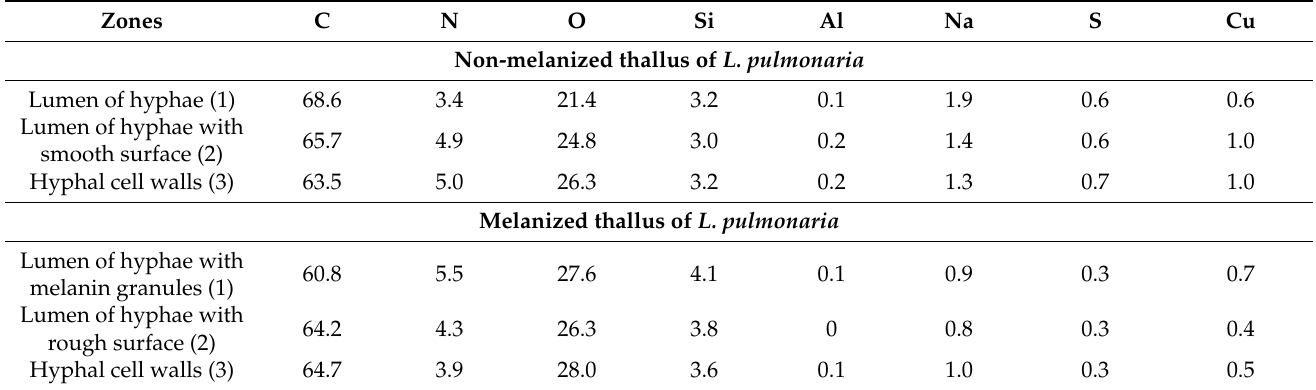
Figure 4. SEM image of cross sections from non-melanized ( A ) and melanized ( B ) Lobaria thalli with three areas selected for elemental composition analysis: ( A )—Lumen of hyphae (1), Lumen of hyphae with smooth surface (2), Hyphal cell walls (3); ( B )—Lumen of hyphae with melanin granules (1), Lumen of hyphae with rough surface (2), Hyphal cell walls (3). SEM image of extracted and purified melanin from Lobaria pulmonaria ( C ) and EDX spectrum of elemental composition (insert). Bar = 1 μ m. In both thalli, all zones were mostly comprised of C, N, and O (Table 1). Interestingly, the relative weight of N in zone 1 with melanin-like granules (Figure 4B) was 1.6 times greater ratio in the melanin granules was c. 11 (Table 1). Si was also present in all selected zones, but in melanin granules the relative weight was on average 1.3 times greater than in the inner surface of the lumen of a pale thallus. Other elements were detected in minor quantities. Table 1. Elemental composition (in %) of three zones in non-melanized and melanized cortical layer of L. pulmonaria.